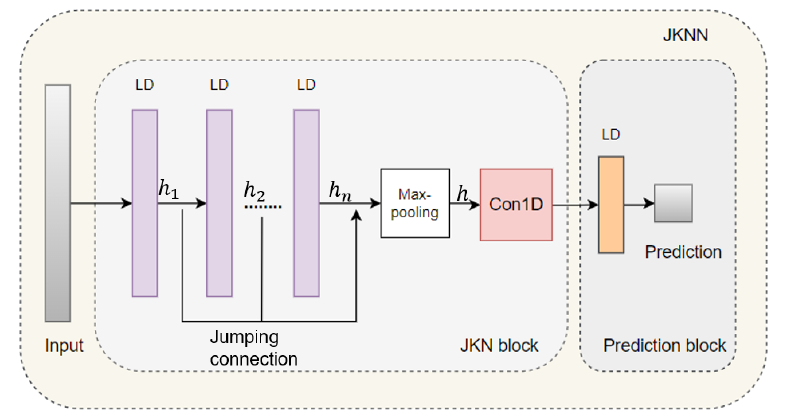
Figure 3. The network structure of JKLNN, where LD is the combination of linear layer and dropout layer to extract hidden information of multiple independent